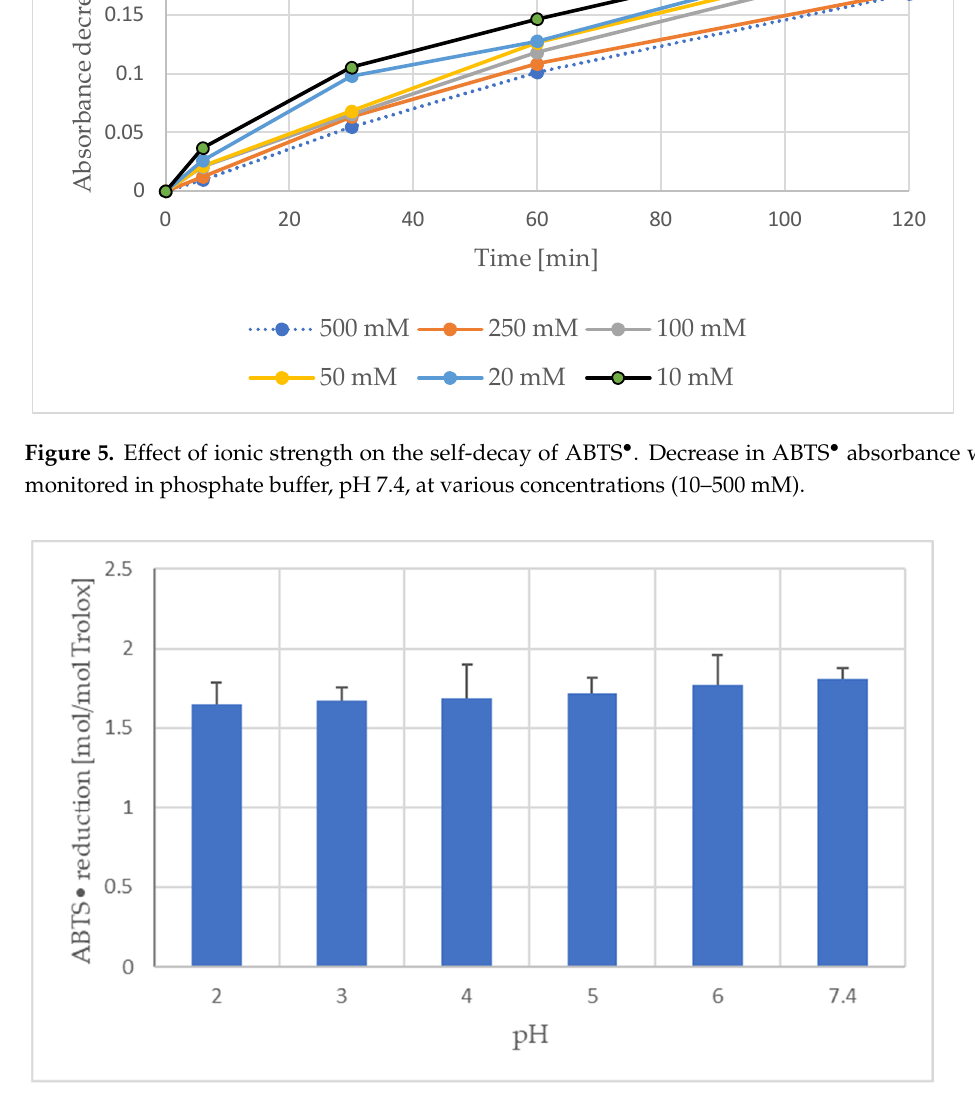
Figure 6. Effect of ionic strength on the reaction of ABTS • with Trolox (5 nmol). ABTS • reduction was measured in phosphate buffer at various concentrations (10–500 mM).